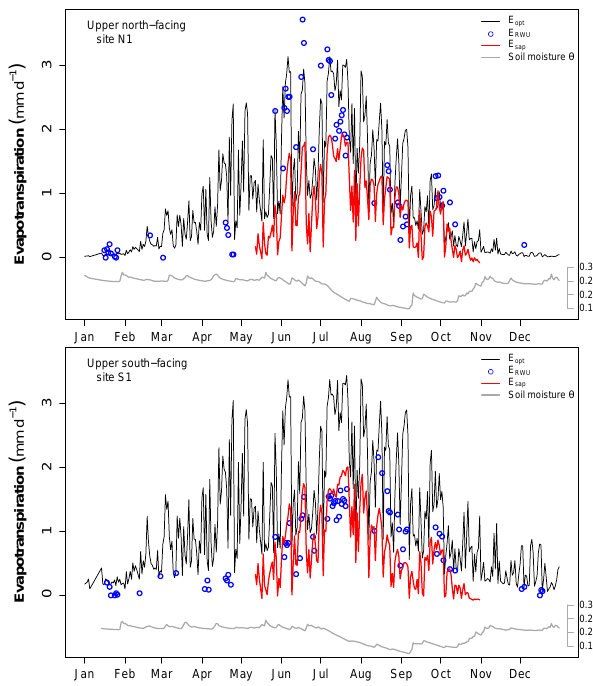
Figure 4. Time series of evapotranspiration estimates for north- facing hillslope site N1 in the left panel and south-facing site S1 in the right panel. E opt is the potential evaporation derived from maximum power, E RWU (blue points) and E sap are transpiration estimates.